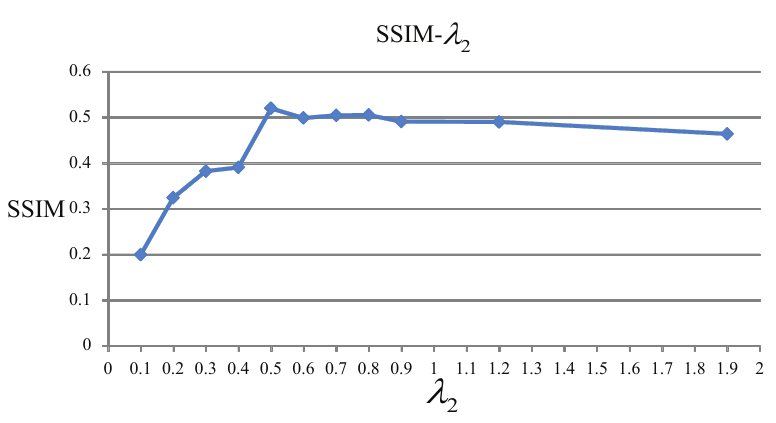
Figure 6. SSIM values with different λ 2 on the